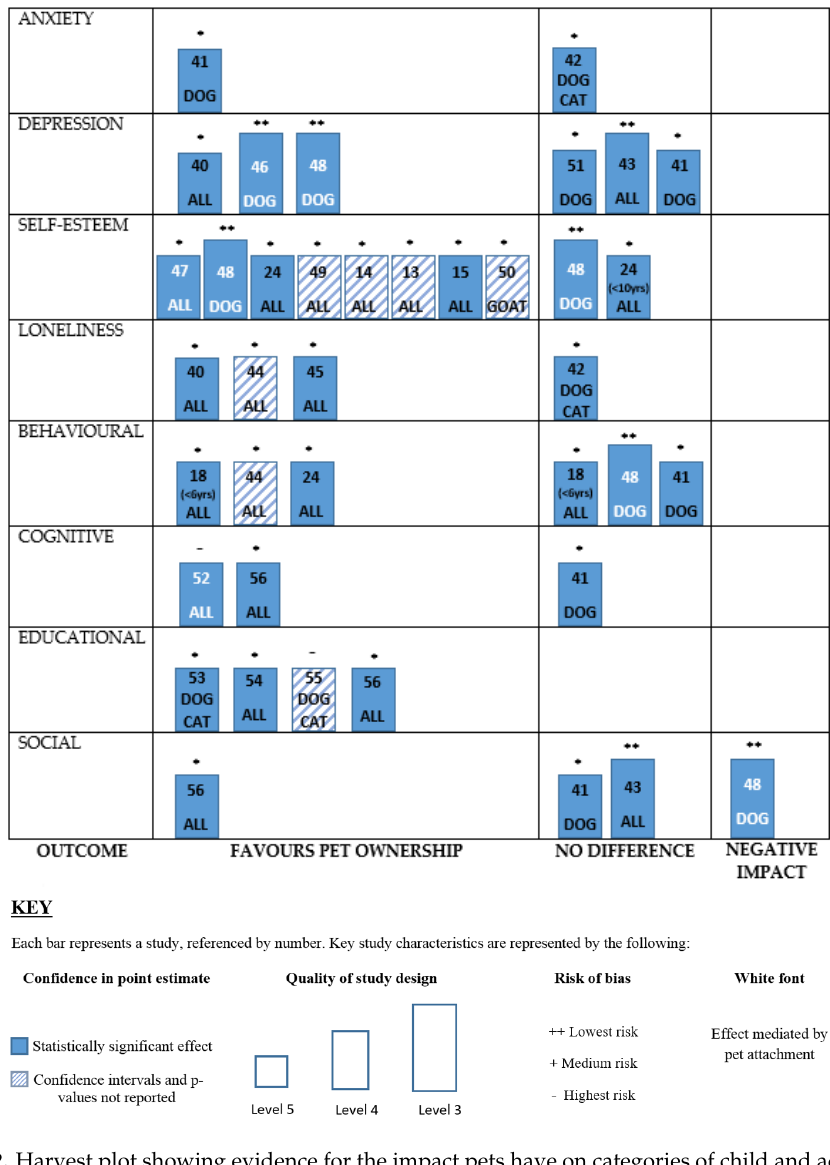
Figure 2. Harvest plot showing evidence for the impact pets have on categories of child and adolescent development. The table consists of eight rows (one for each dimension of development) and three columns (showing the differential effects of the evidence in each category). Each study is represented by a bar in each row; studies can be identified by reference number. Statistically significant effects (use of p -values) are indicated with solid blue bars, and studies with no confidence intervals and p -values reported are striped bars. The quality of study design is indicated by the height of the bar as categorised by OCEBM level of Evidence 2011. Each bar is annotated with marking to show risk of bias.